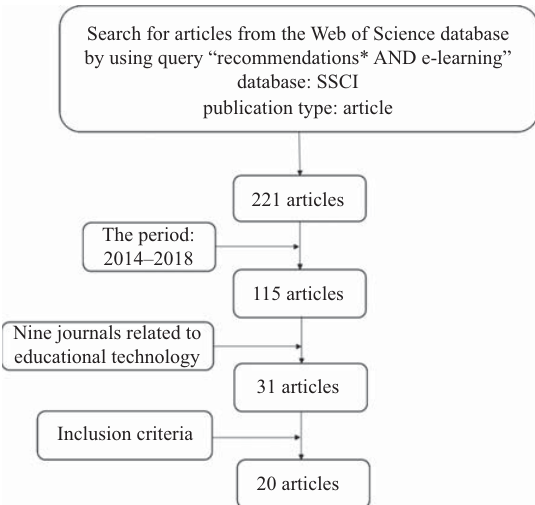
Figure 3. The process of